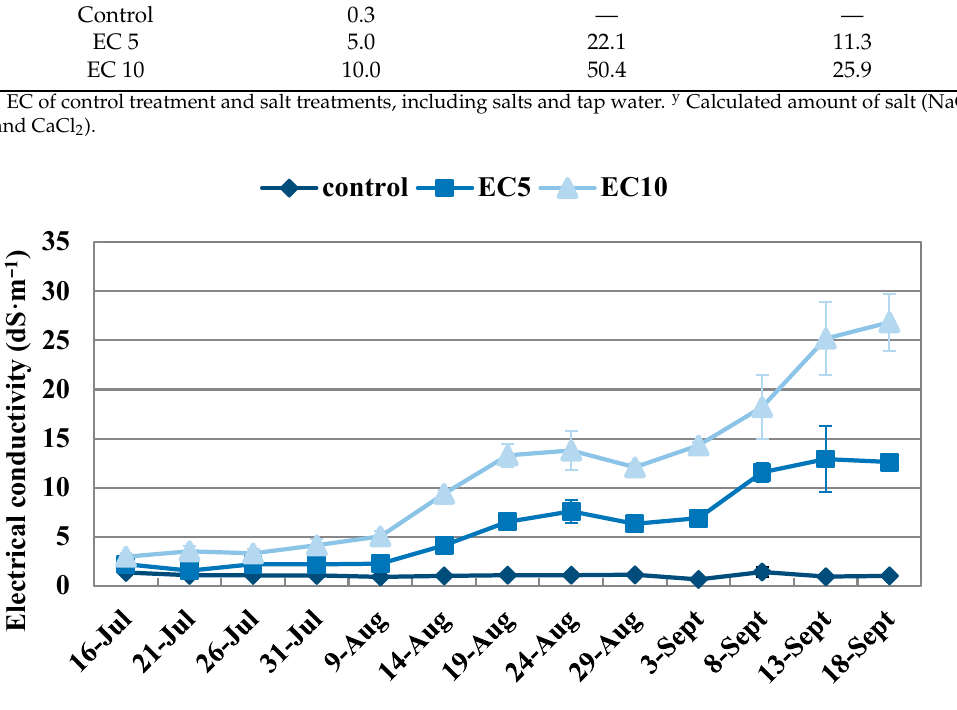
Table 2. The electrical conductivity (EC) and composition of control and salt solutions used in the study. Treatment